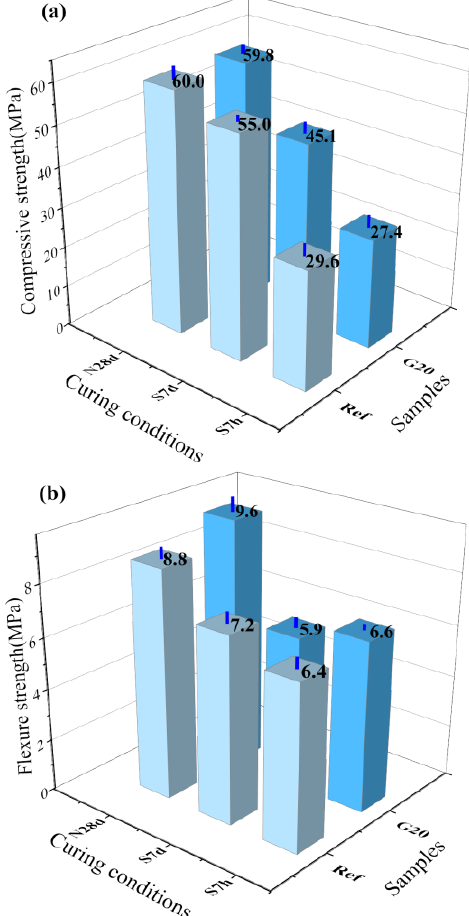
Figure 12. Strength of GBFS blended cement mortars, ( a ) compressive strength, ( b ) flexural strength.